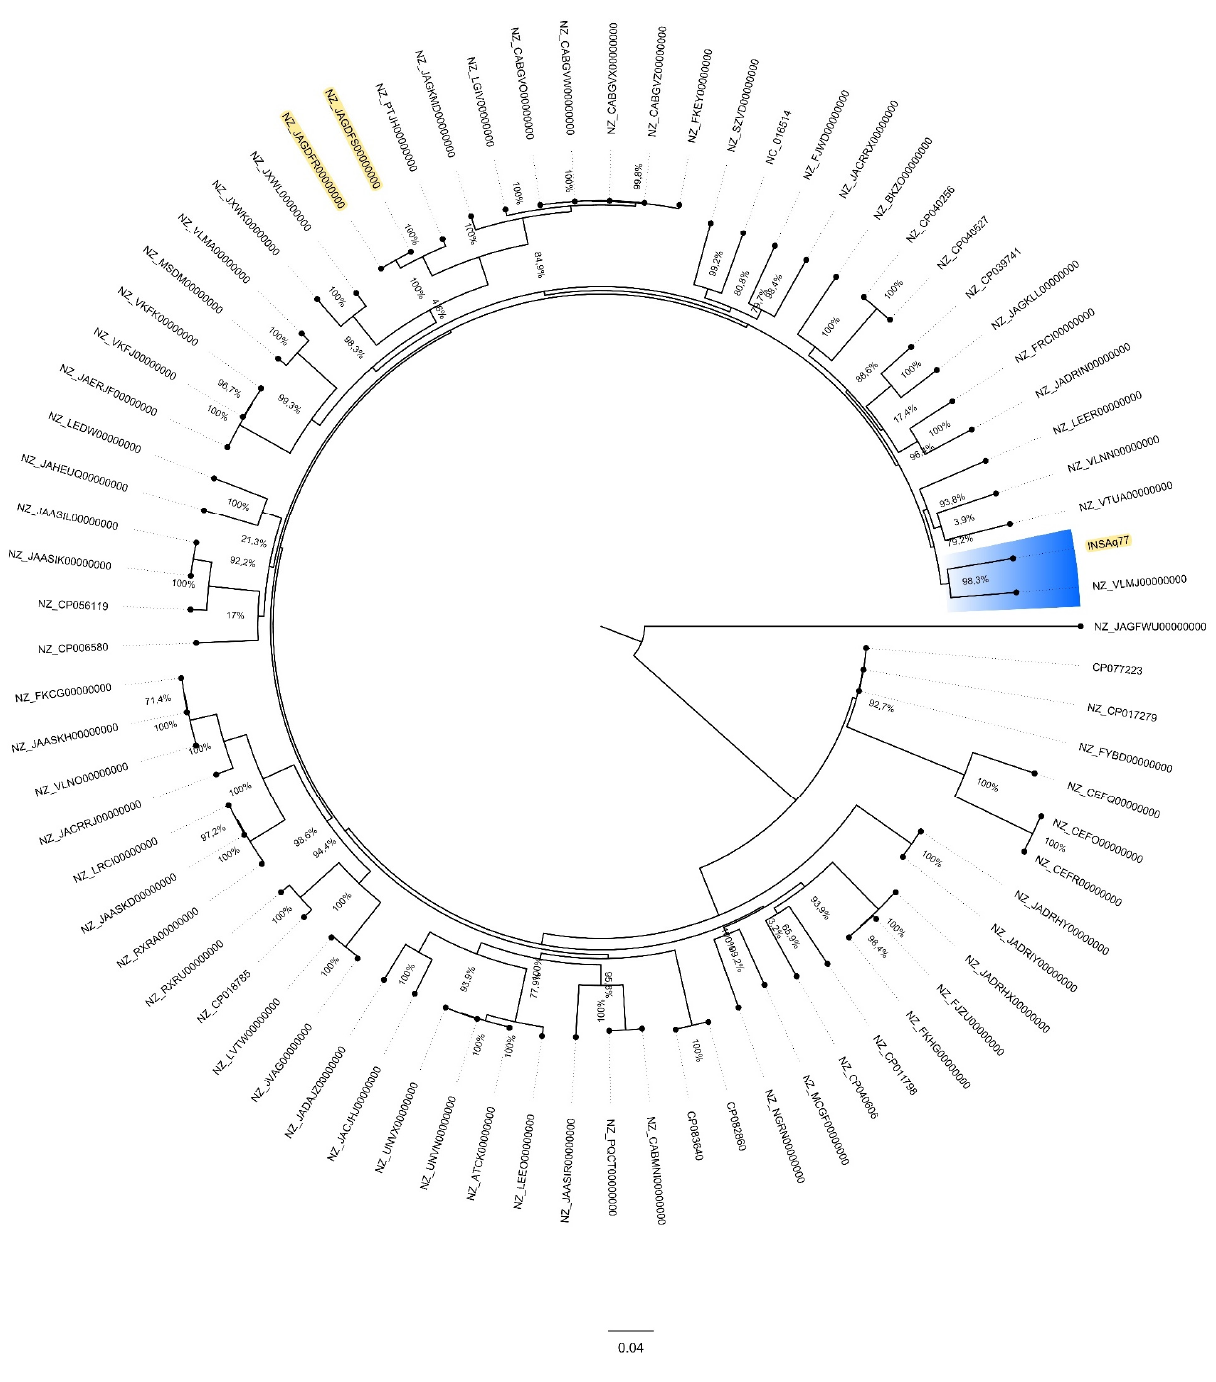
Figure 1. Whole-genome SNP-based phylogenetic tree showing the relationship between 75 E. ludwigii genomes. The scale bar indicates 4% of nucleotide sequence divergence. The numbers at the nodes indicate percentage bootstrap replicates of 100. Sequences in the tree are indicated as GenBank accession number. Strain of the present study and the other MCR-9-producing isolates are highlighted in yellow. Blue colour indicates cluster containing INSAq77.